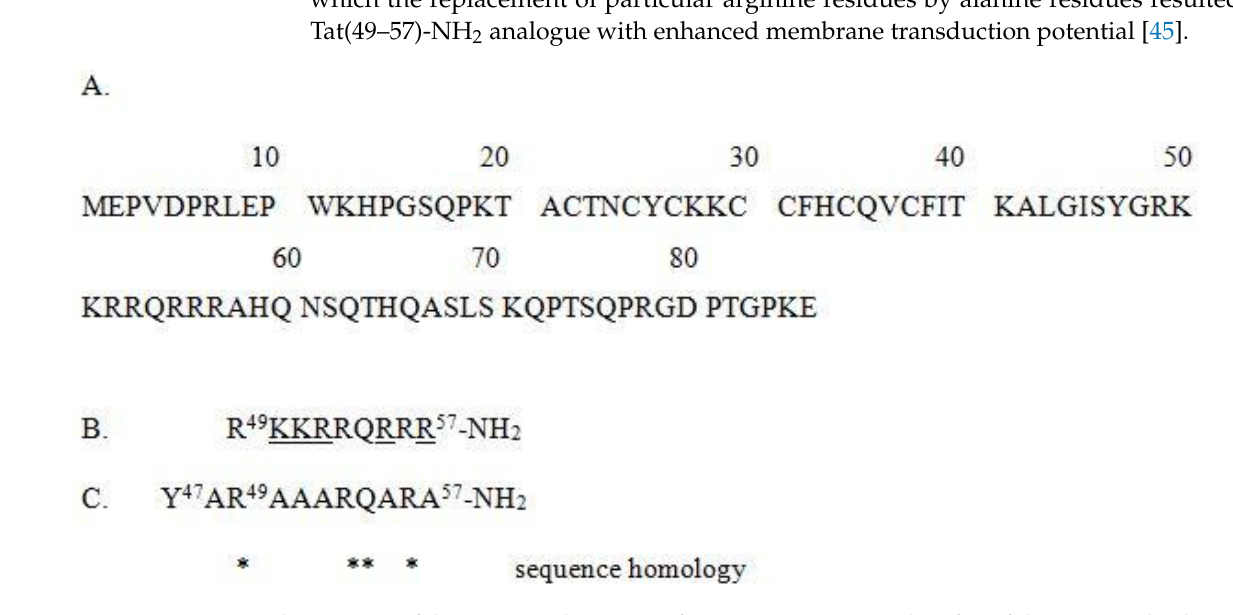
Figure 1. ( A ) Amino acid sequences of the “canonical” variant of HIV-1 Tat (P04608-1 identifier of the UniProt database), ( B ) Tat(49–57)-NH 2 with underlined Ala-substituted residues, and ( C ) PTD4. Asterisks (*) indicate positions of sequence homology (R, R, Q, R).